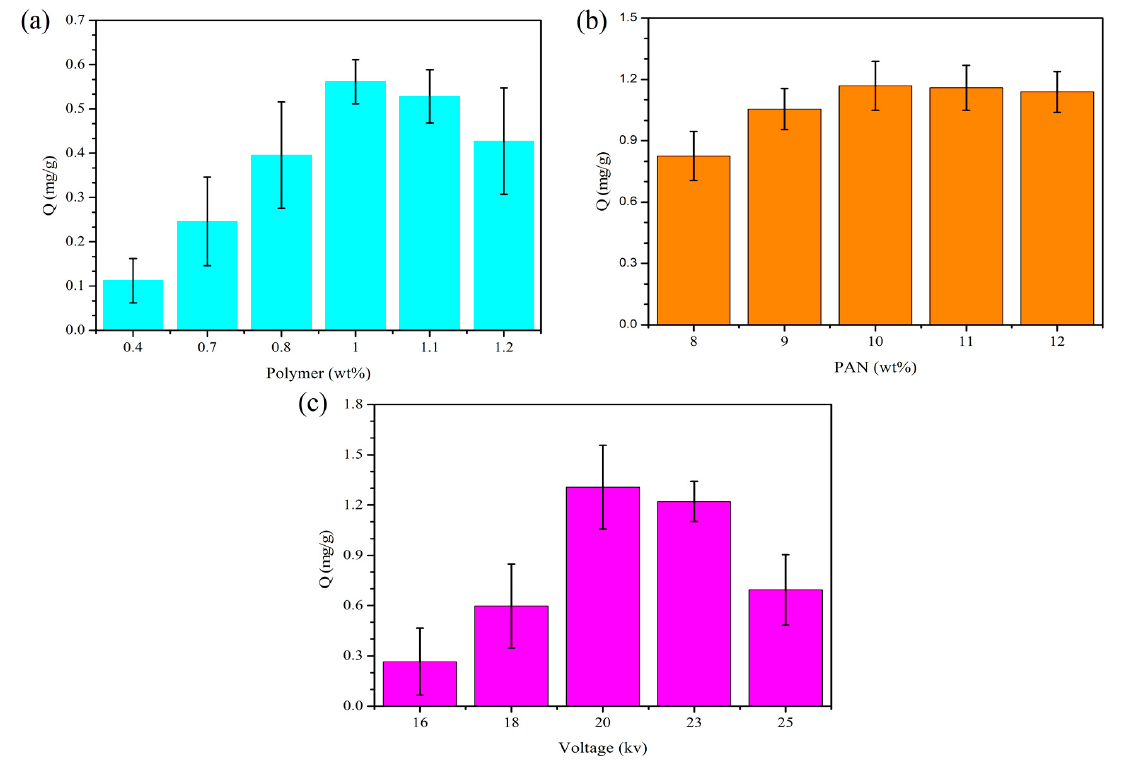
Figure 4. Optimization preparation conditions of the RCMs: ( a ) Polymer content; ( b ) PAN content; ( c ) Voltage adsorption amount.